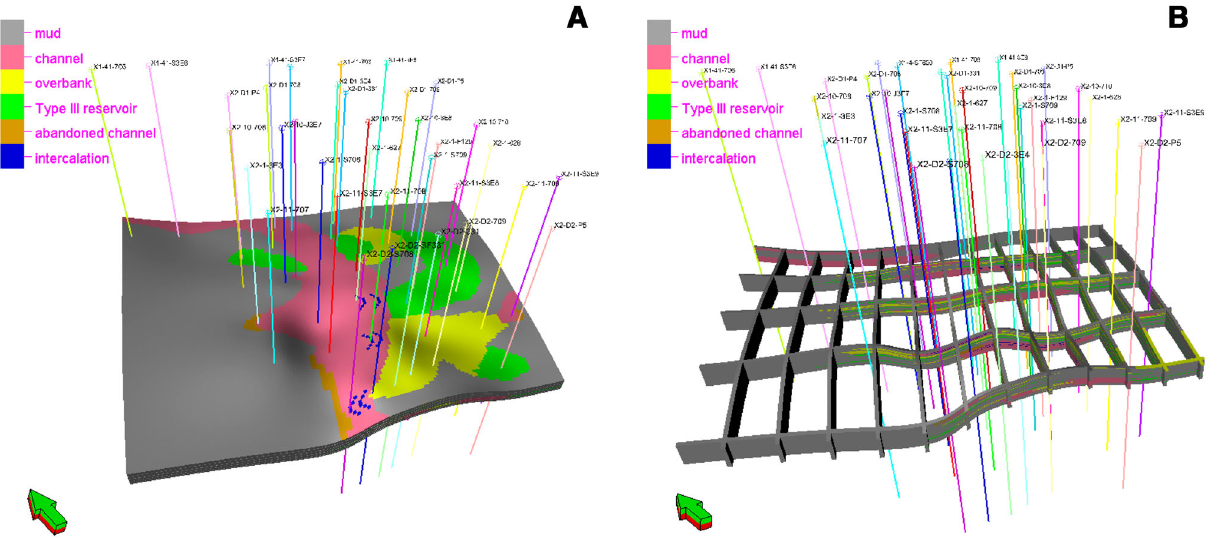
Fig. 8 Facies models in the study area. a Facies model of the S2 layer set in the study area; b facies fence model of the S2 layer set in the study